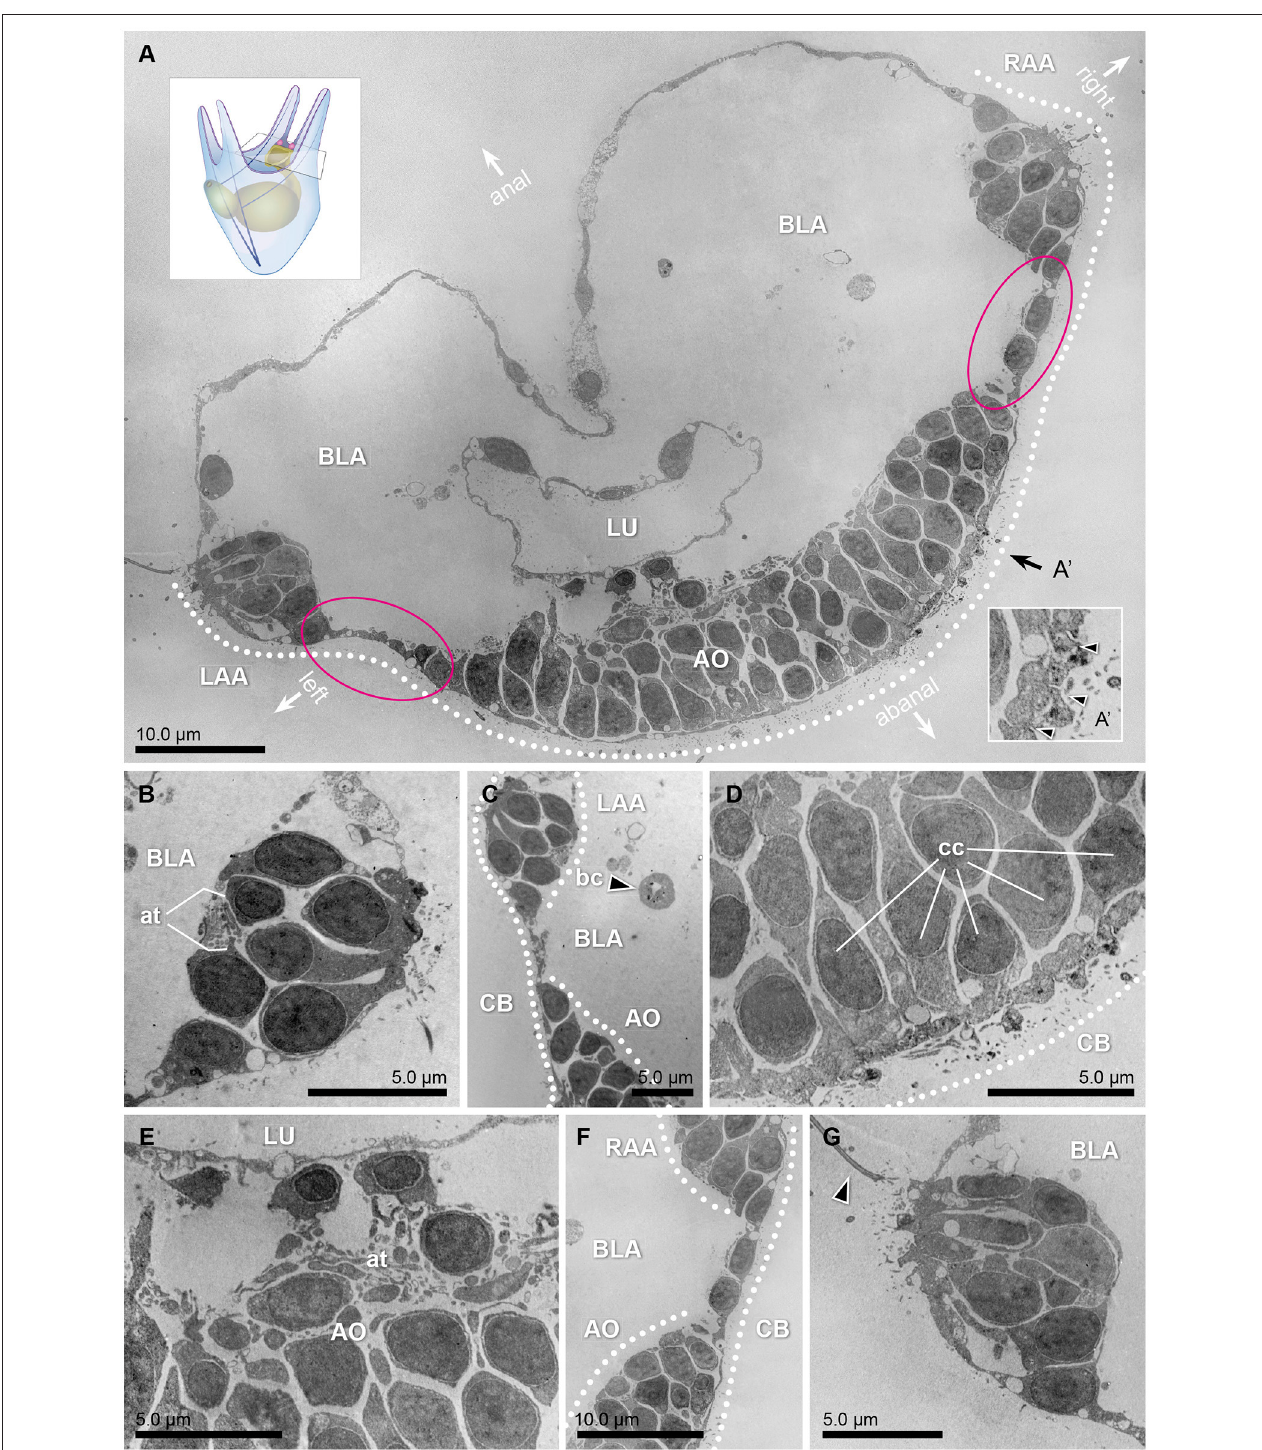
FIGURE 3 | Transmission electron micrographs of a 3dpf (early 4 armed) pluteus, different sections of three specimens at the level of the apical region. (A) Collage of 324 transversal micrographs showing a panoramic view of the abanal half of the larvae (apical region). On it, the bases of the left and right anterolateral arms (LAA and RAA, respectively), as well as the lumen (LU) of the gut, surrounded by the blastocoel (BLA), the ciliary band (CB, dotted line), and the apical organ (AO) are shown. The stippled line corresponds to the ectodermal region in which the ciliary band is located. A representation of the whole 4 armed pluteus larva and